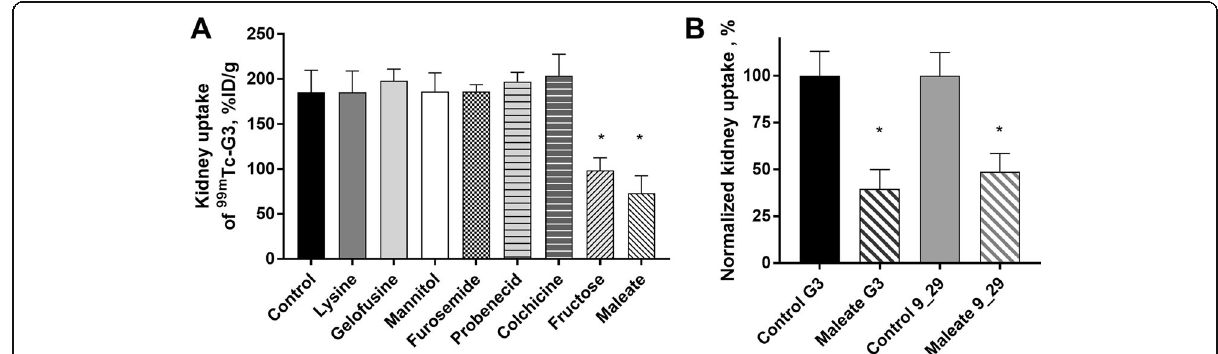
Fig. 1 Kidney uptake of radiolabeled DARPins in female NMRI mice at 4 h pi. a The effect of different compounds on the kidney uptake of [ 99m Tc]Tc(CO) 3 -G3 in %ID/g. An asterisk marks a significant difference from the control (* p < 0.0001, one-way ANOVA test). Data are presented as the average of mice ± SD, for the control — as the average of eight mice ± SD. b The kidney uptake of both radiolabeled DARPins [ 99m Tc]Tc(CO) 3 - G3 and [ 99m Tc]Tc(CO) 3 -9_29 was decreased when maleate was administered 5 min before the DARPins. An asterisk marks a significant difference from the control (* p < 0.001, unpaired t test). Data are presented as average from four mice ±